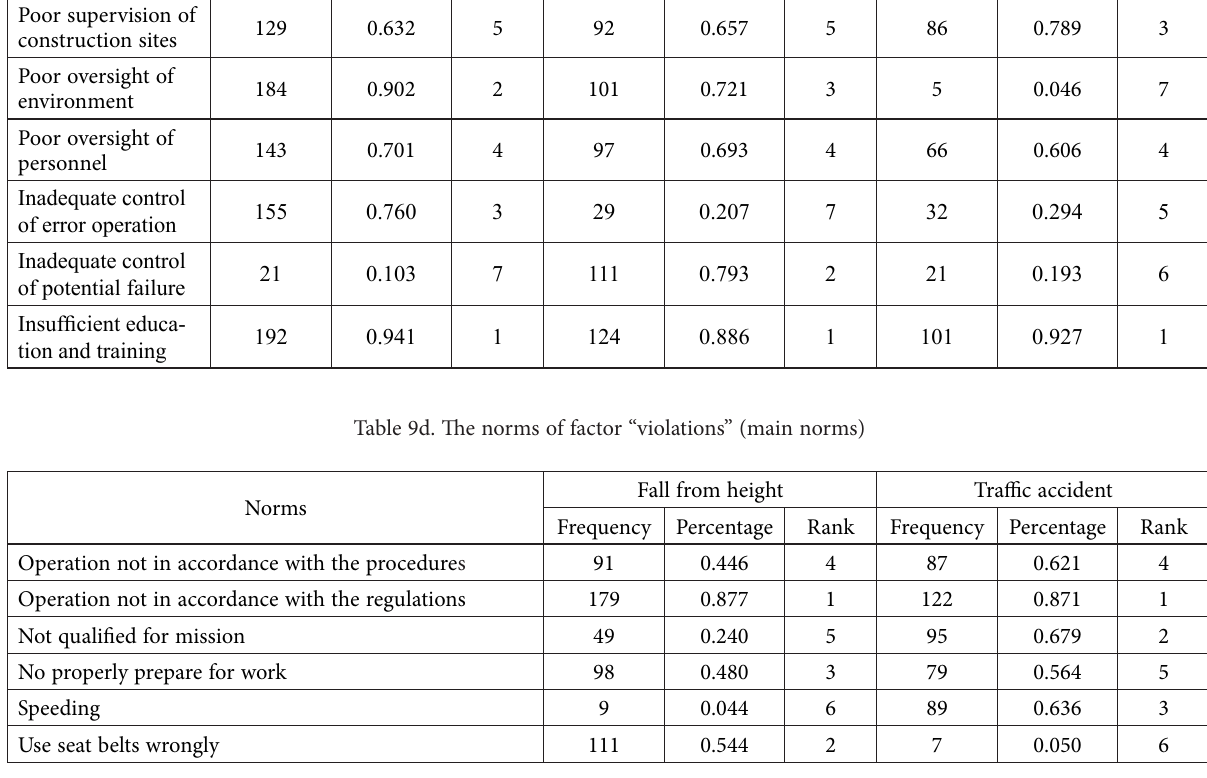
Table 9e. The norms of factor “technological